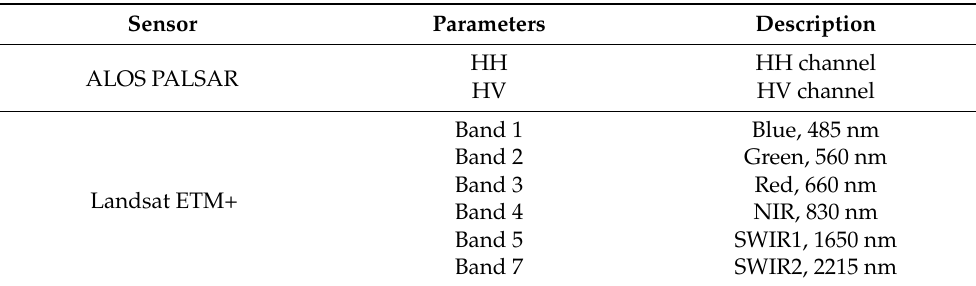
Table 1. Detail information about variables used for fuel load modeling. ALOS: Advanced Land Observing